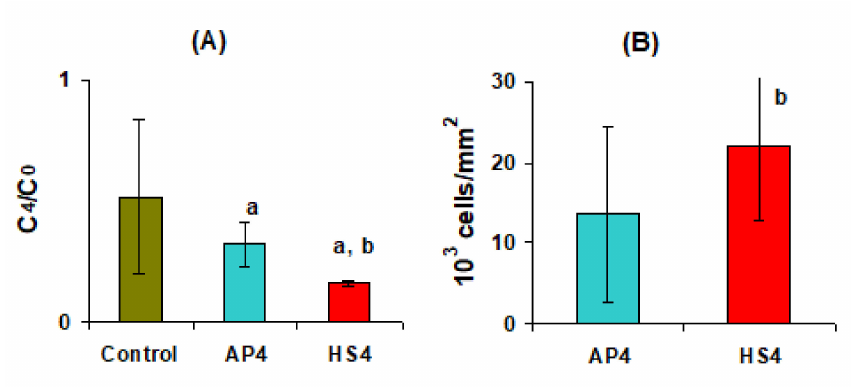
Figure 16. LPS adsorption ( A ) and macrophage adhesion ( B ) on the AP4 and HS4 gel beads during incubation for 4 h in Hanks’ solution supplemented with 10% FBS, 10 µ g/mL LPS, and 2 × 10 6 peritoneal macrophages. The data are presented as the mean ± S.D. (n = 12). a and b — p < 0.05 vs. Control and AP4 gel beads, respectively. C 4 /C 0 —relative concentration, where C 0 and C 4 are the initial and remaining concentrations of LPS in Hanks’ solution after 4 h of incubation, respectively.